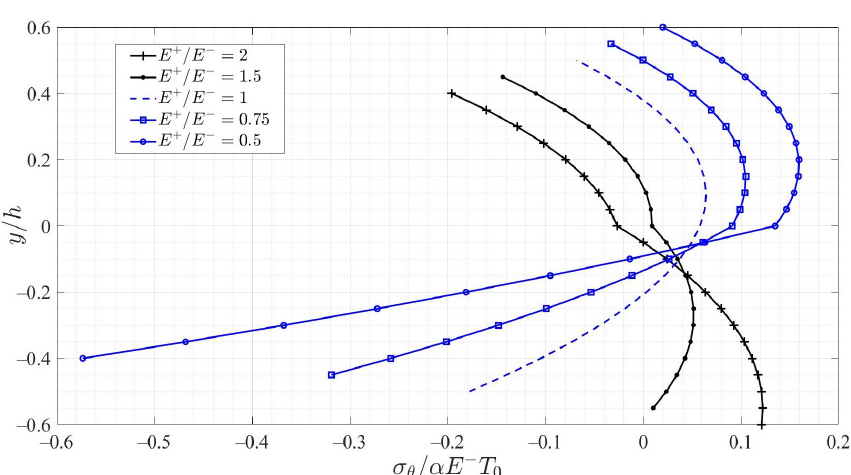
Figure 5. Thermal stress variation along thickness direction under linear temperature rise.